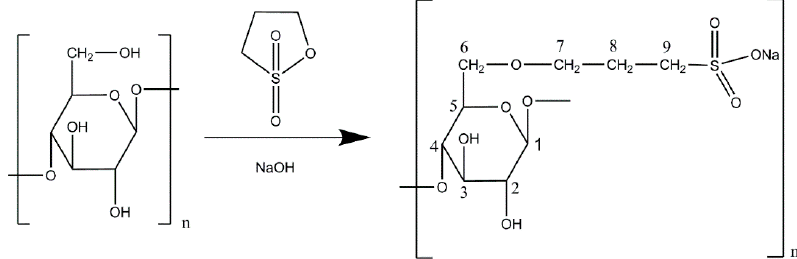
Figure 1. Synthesis of γ -propoxy-sulfo-lichenan (PSL) from lichenan and γ -propan sulton under alkaline conditions.